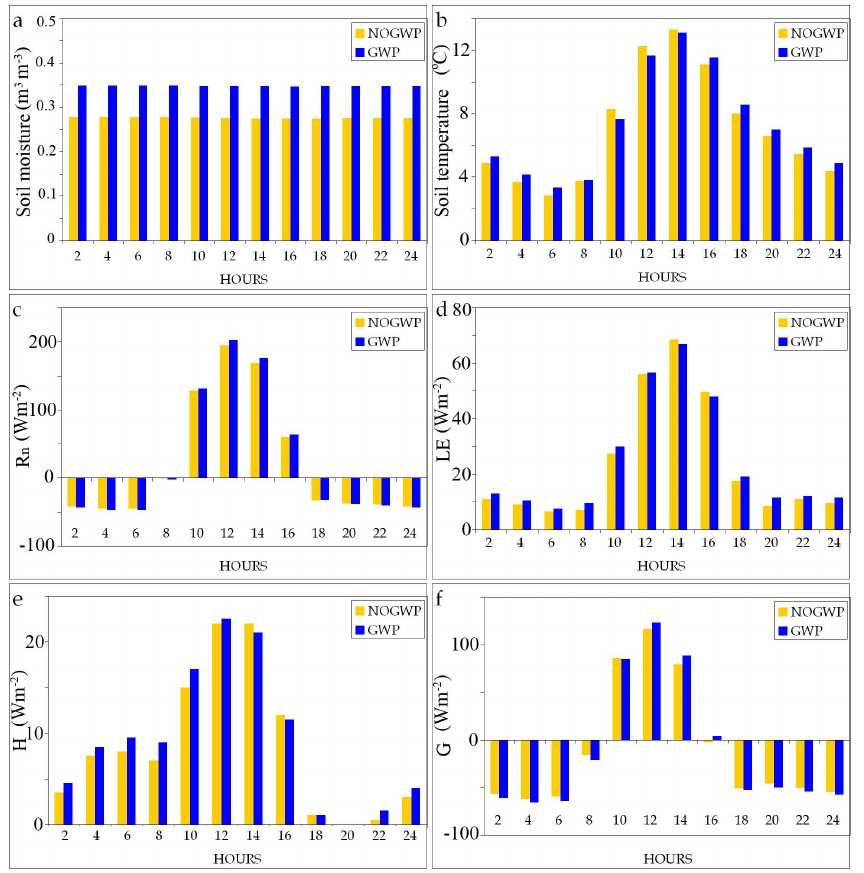
Fig. 4. The surface soil moisture, the surface soil temperature and the surface energy balance components of the two profiles on a winter day (3 January of the simulated